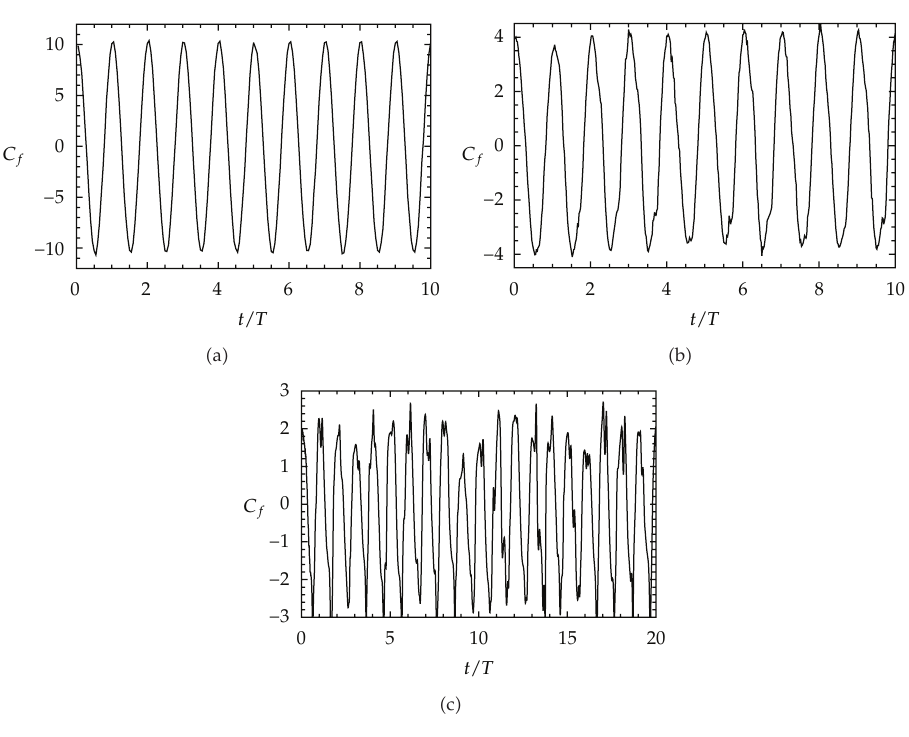
Figure 10: Time histories of C f of the first cylinder at KC (cid:8) 2, 5, and 10.